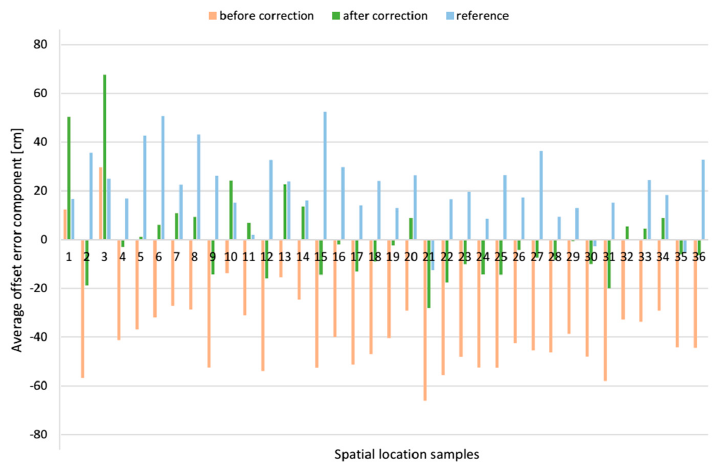
Figure 22. Comparative bar plots of the average offset errors of the z components for AD pair.